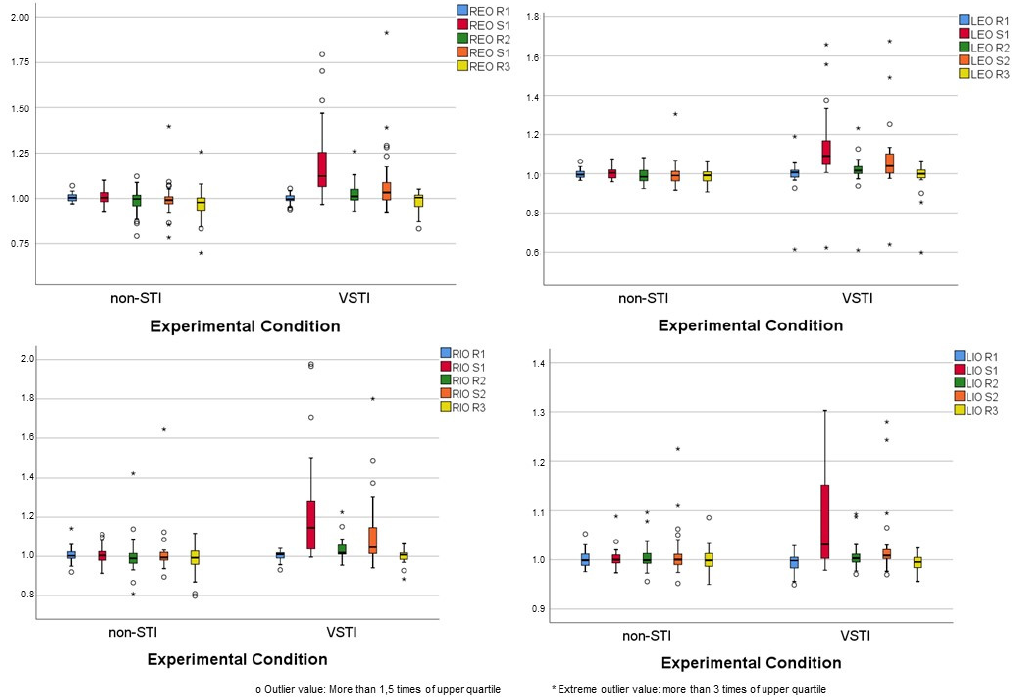
Figure 2. Box plot of electric muscle activity recorded in both experimental conditions in each muscle. REO: Right external oblique; LEO: left external oblique; RIO: right internal oblique; LIO: left internal oblique; R1: repose pre-stimulus; S1: right-side stimulus; R2: rest between S1 and S2; S2: left-side stimulus; R3: repose post-stimulus; non-STI: control experimental condition; VSTI: Vojta experimental condition.